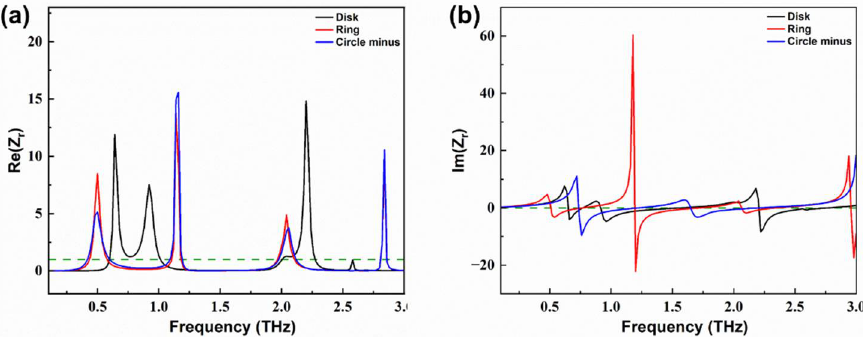
Figure 4. ( a ) Real parts and ( b ) imaginary parts of the relative impedance of different patterns of the graphene THz metamaterials absorbers.